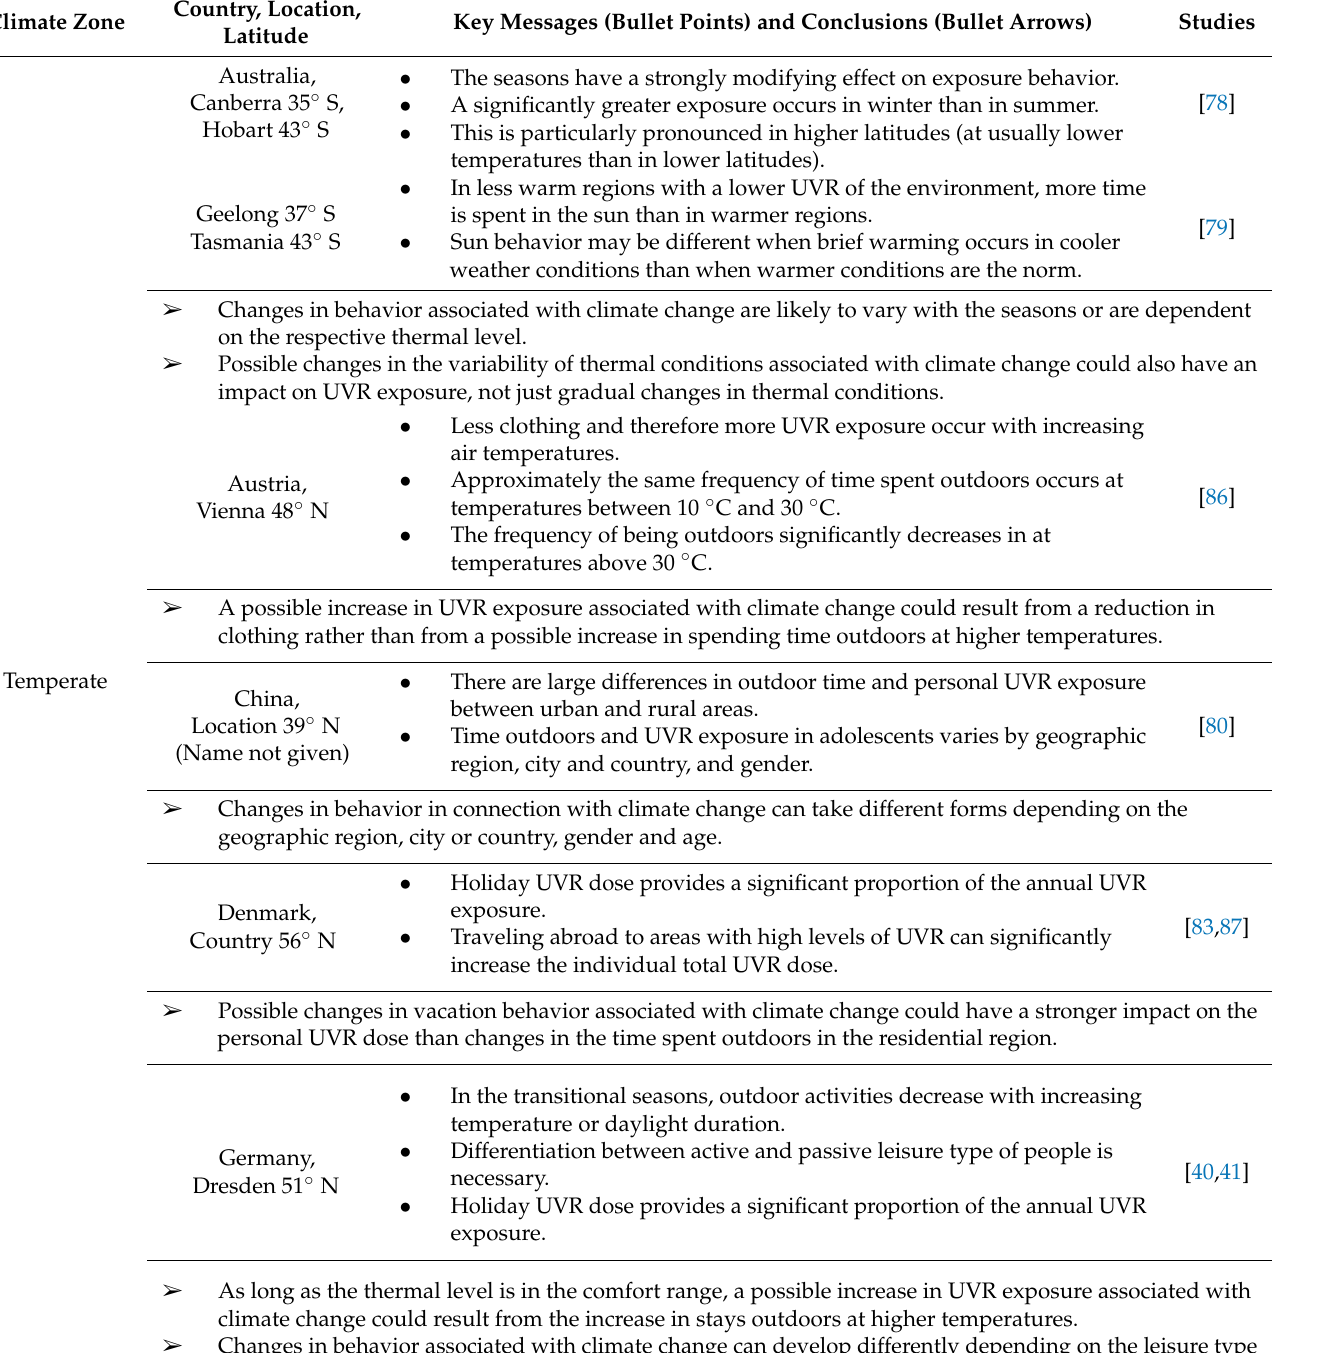
Table 6. Summary of the key messages and conclusions from the type III studies. Climate Zone Key Messages (Bullet Points) and Conclusions (Bullet Arrows)